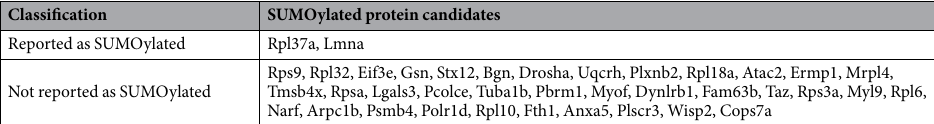
Table 1. The SUMOylated protein candidates identified by cDNA analysis of the fluorescent cells sorted by FACS.